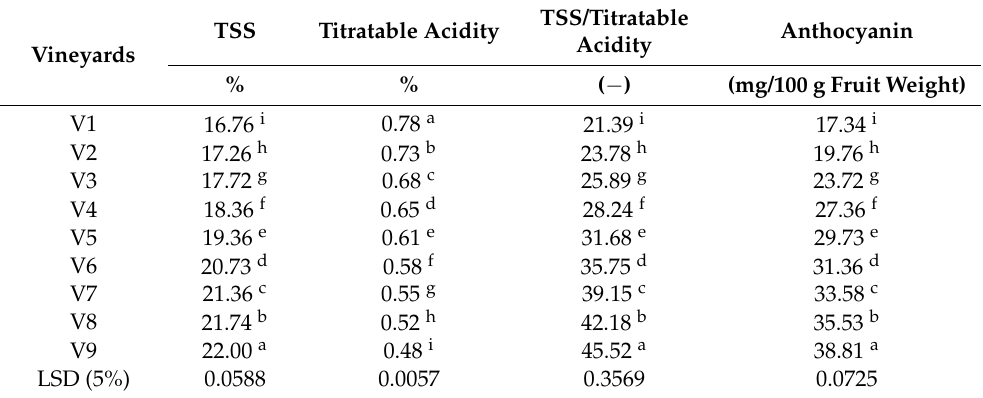
Table 3. Distribution of mean values of internal quality (TSS, titratable acidity, TSS/acidity, and anthocyanin) of Flame Seedless grape berries cultivated under various agronomical management and other